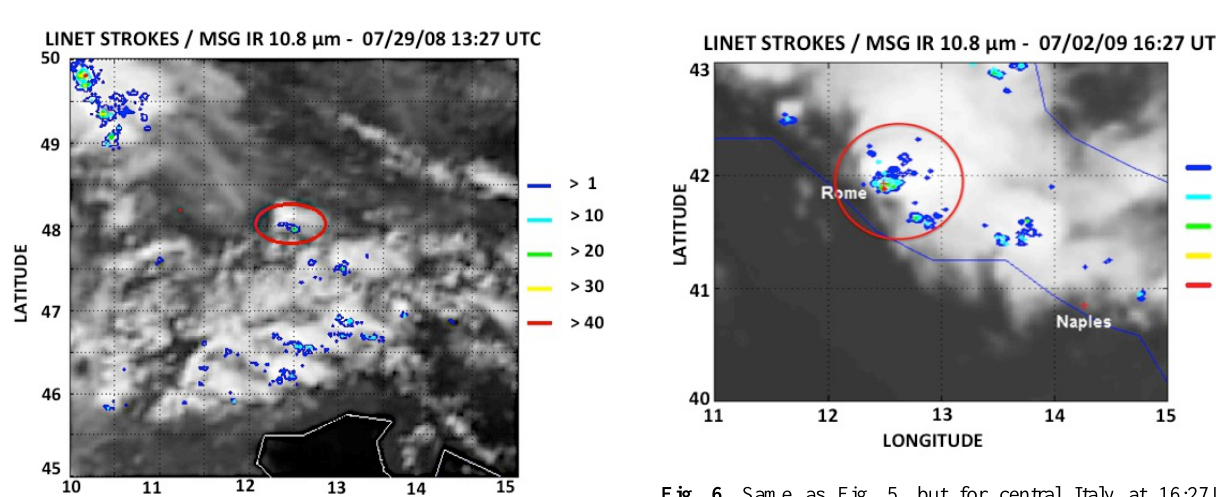
Fig. 6. Same as Fig. 5, but for central Italy at 16:27UTC, 2 July 2009. The red circle identifies the area selected for Case 2 and the red crosses identify the cities of Rome and